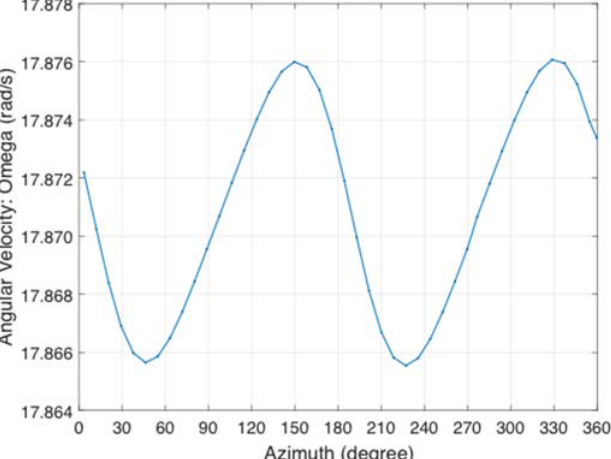
Figure 14. Variation of angular velocity 𝜔 as a function of azimuthal angle in the torque ‐ controlled system at TSR = 3.3.